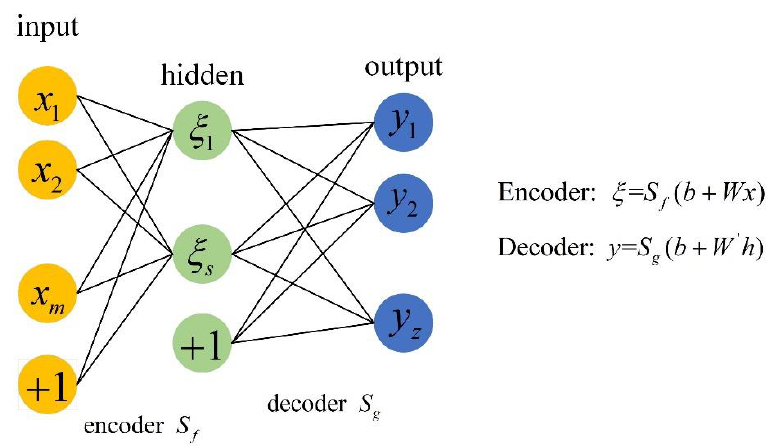
Figure 3. Structure of AE.